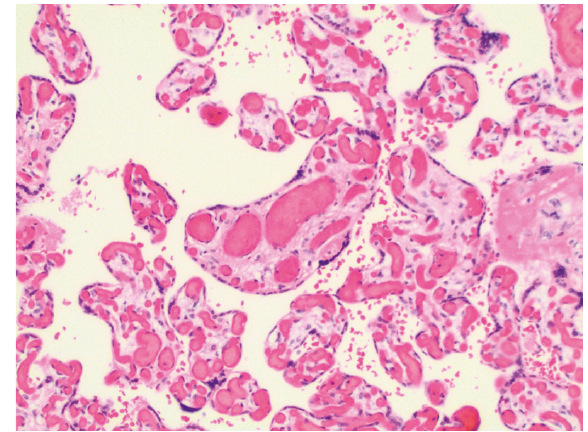
Figure 3: Chorionic villi with evidence of chorangiosis; more than 10 capillaries in at least 10 terminal villi in low-power fields